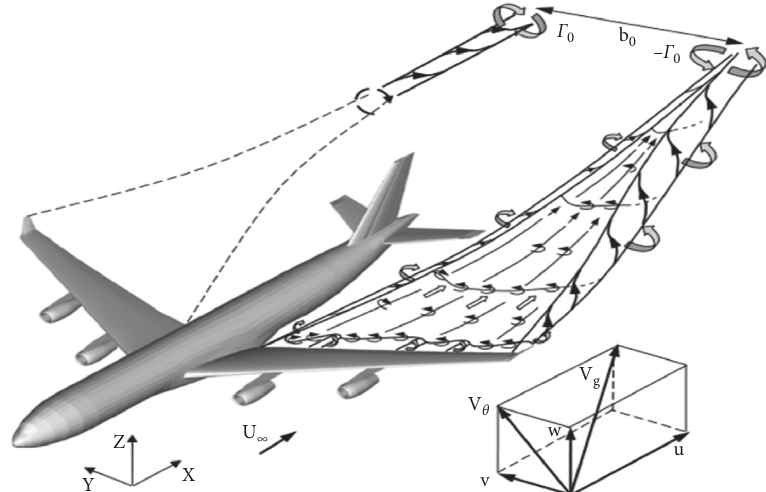
Figure 2: Wake generation and winding